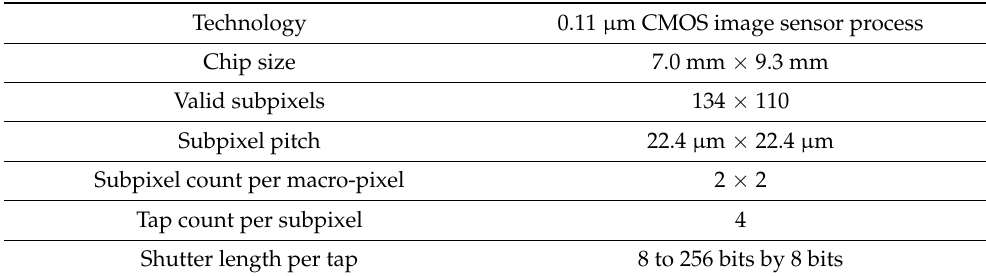
Figure 2. Structure of multi-tap macro-pixel computational CMOS image sensor. Each macro-pixel is composed of four subpixels. The subpixel is implemented by a four-tap LEFM with charge drain. Table 2. Specifications of multi-tap macro-pixel computational CMOS image